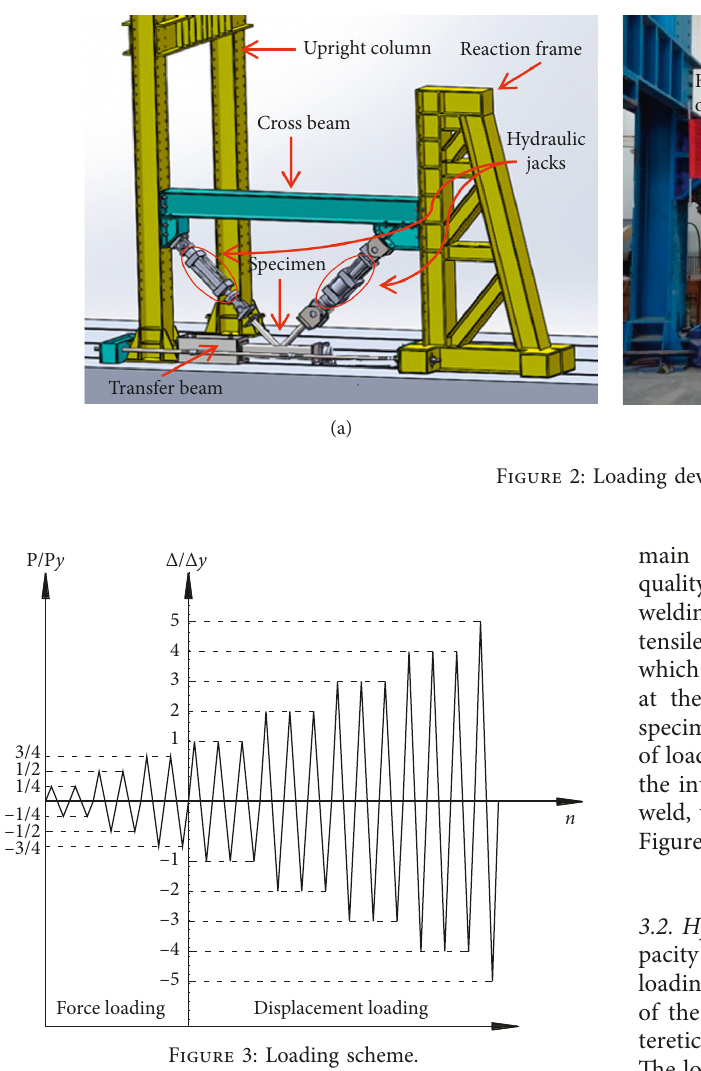
Figure 3: Loading